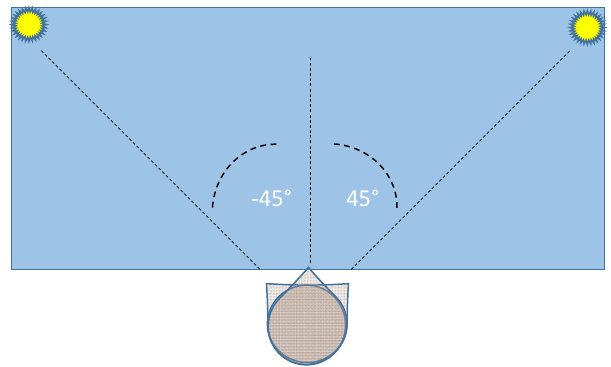
Figure 2. Top vision of the layout of the experimental set environment.